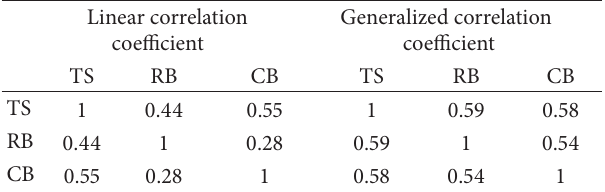
Table 4: Linear and generalized correlation coefficients between different business